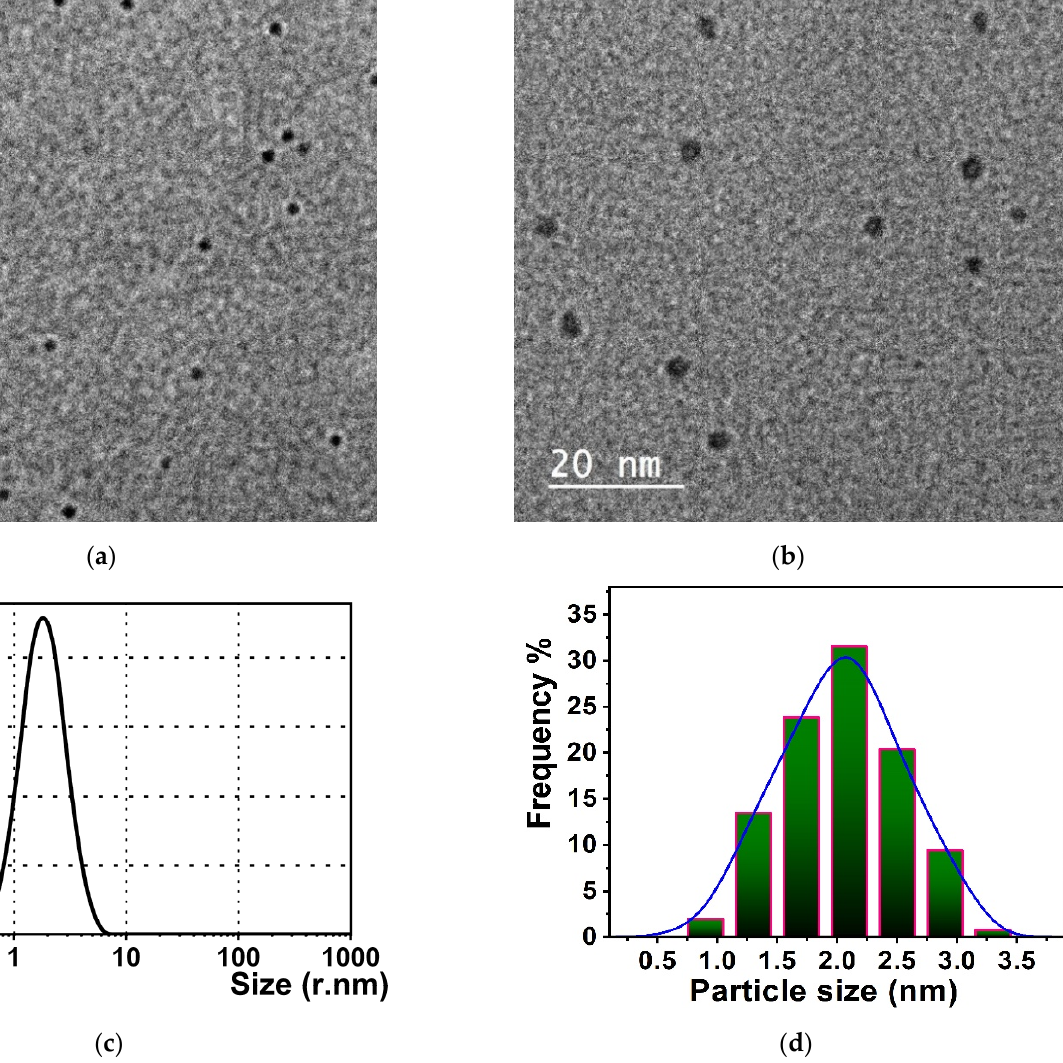
Figure 2. ( a,b ) TEM images, ( c ) DLS, and ( d ) SD histogram of the as-prepared